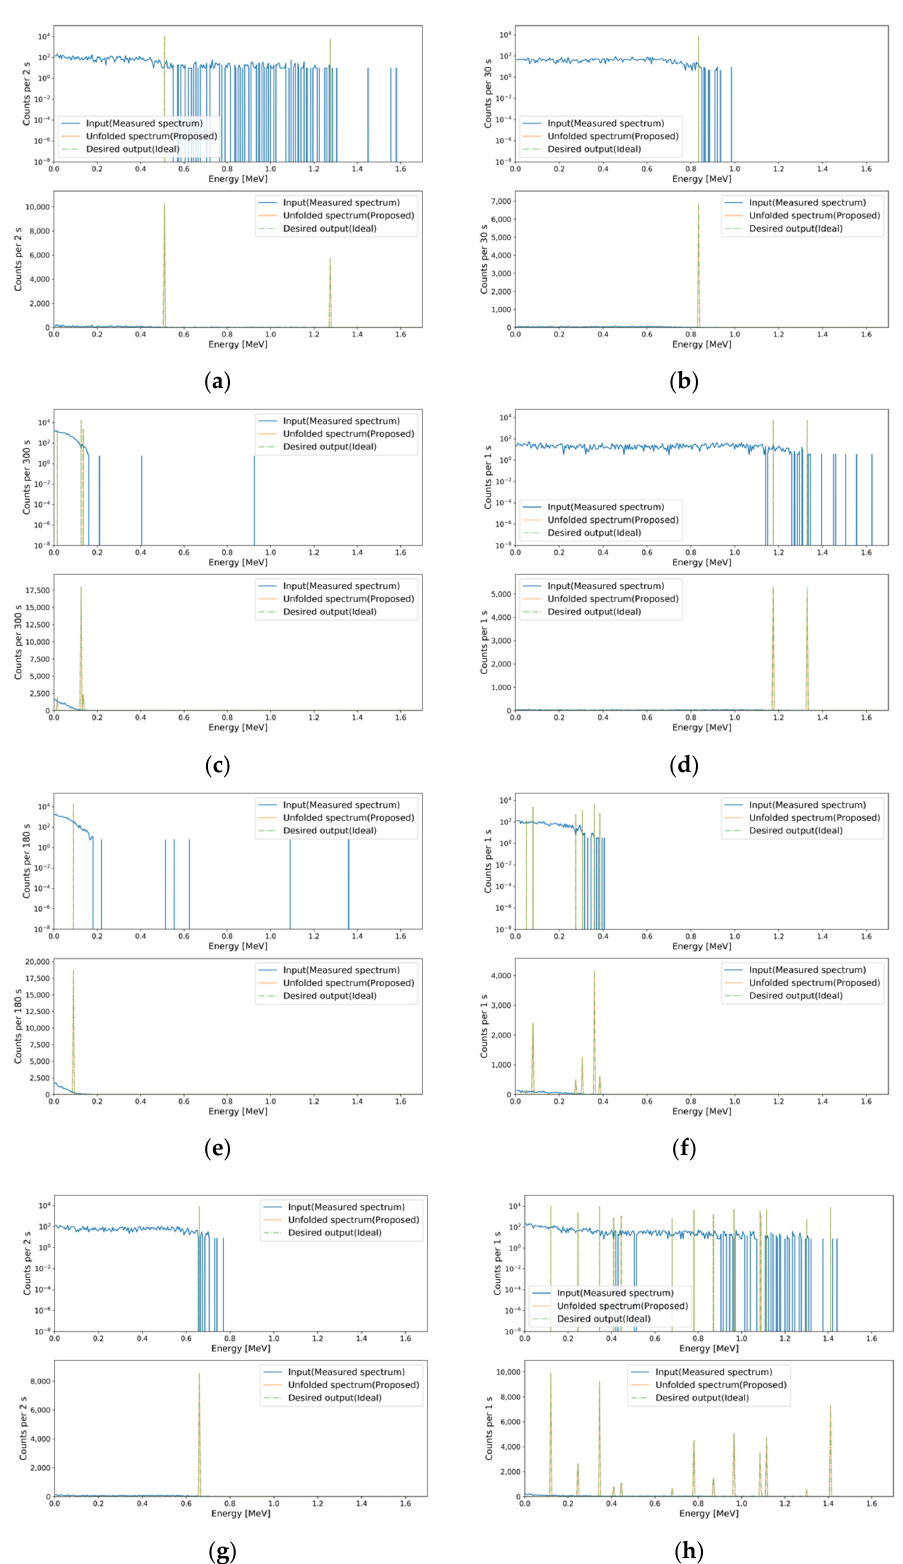
Figure 9. FEP generation results for the measured spectra at each MRC. For the eight gamma − ray sources, the MAPEs are ( a ) 3.999 × 10 − 1 for 22 Na; ( b ) 1.999 × 10 − 1 for 54 Mn; ( c ) 5.999 × 10 − 1 for 57 Co; ( d ) 3.999 × 10 − 1 for 60 Co; ( e ) 1.999 × 10 − 1 for 109 Cd; ( f ) 1.999 × 10 − 1 for 133 Ba; ( g ) 1.999 × 10 − 1 for 137 Cs; and ( h ) 2.799 × 10 − 1 for 152 Eu.